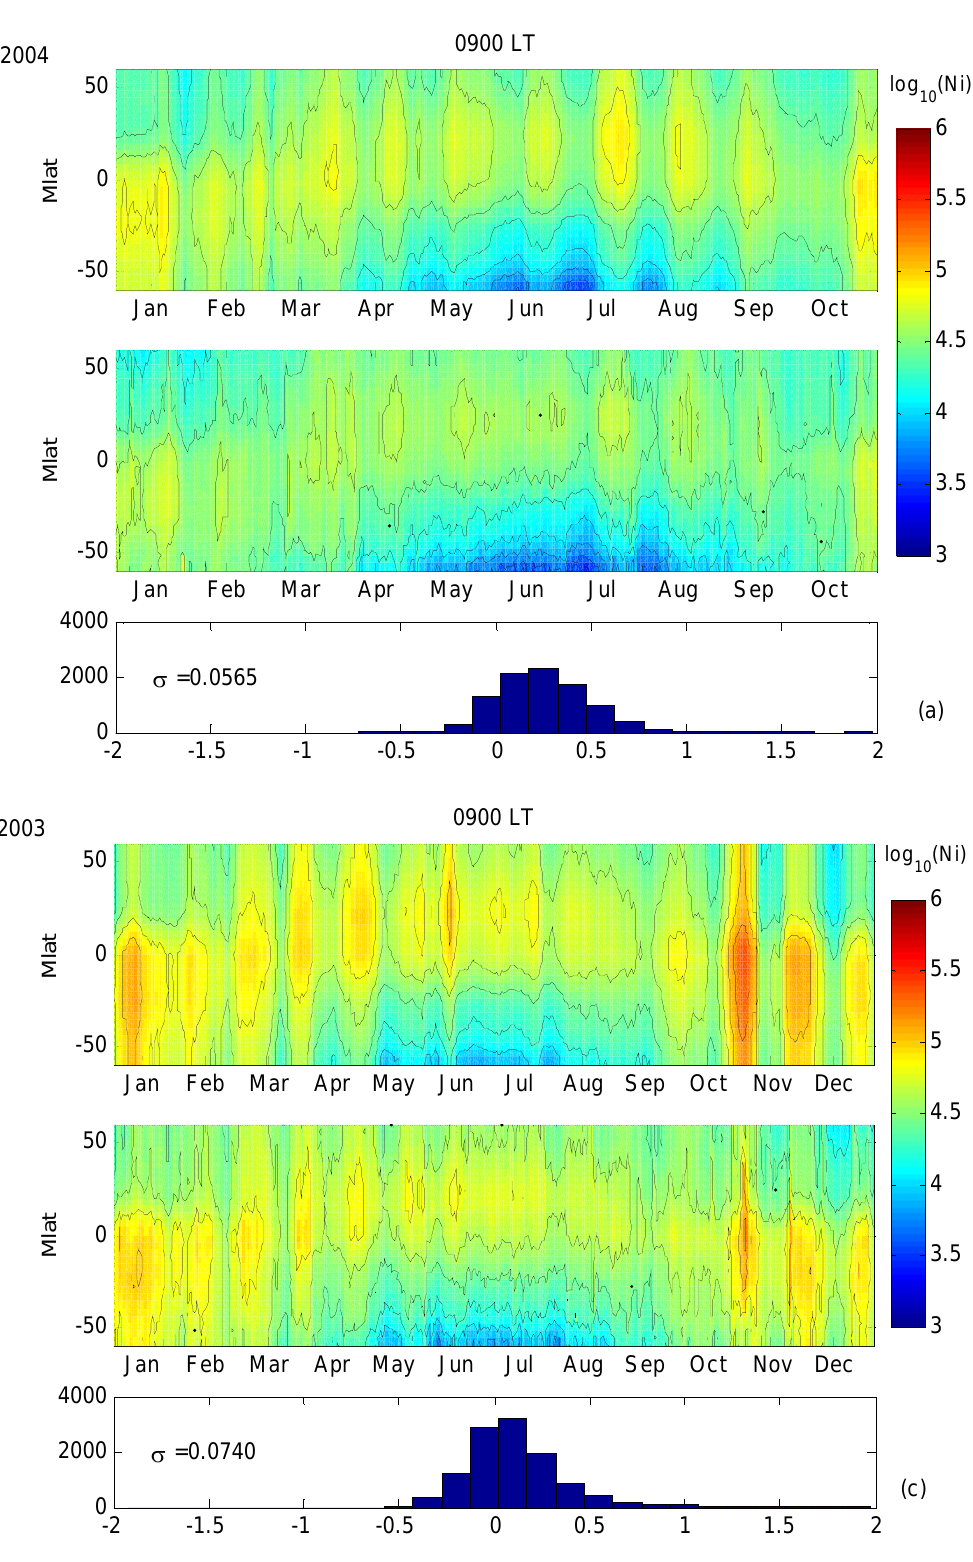
Fig. 11. Comparison between the predicted and observed Ni for the year 2004 at 09:30 LT (a) , year 2003 at 09:30 LT (b) , year 2003 at 21:30 LT (c) . The bottom panel of each figure represents the histogram of the percentage